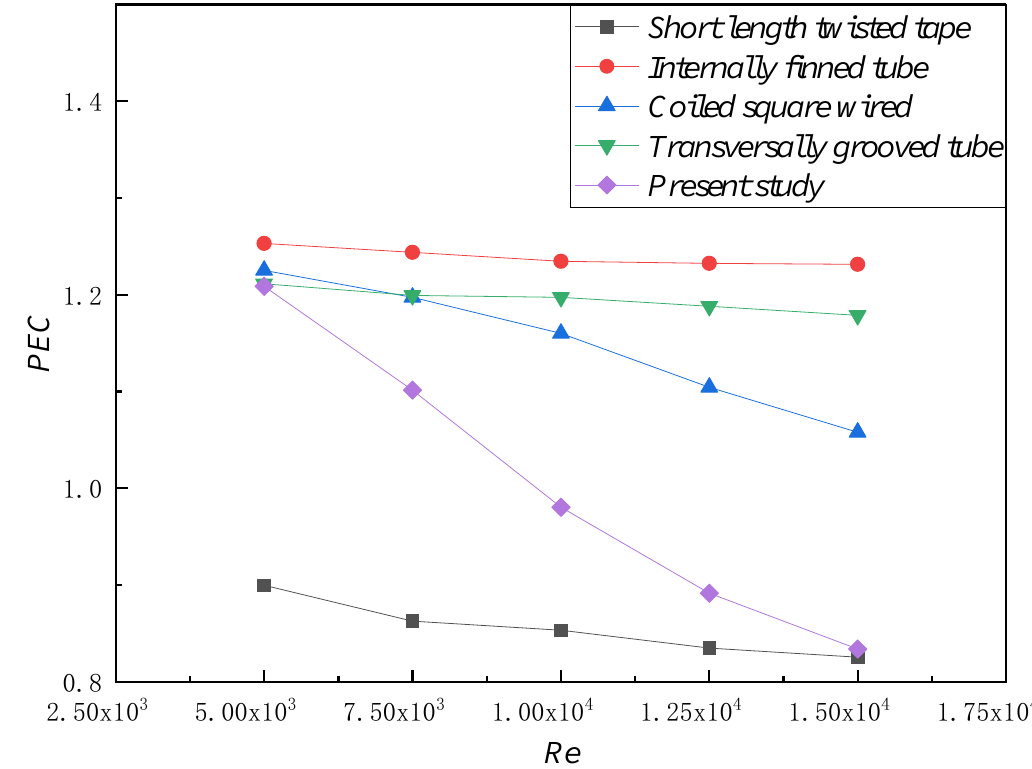
Figure 11. Comparisons with previous work.